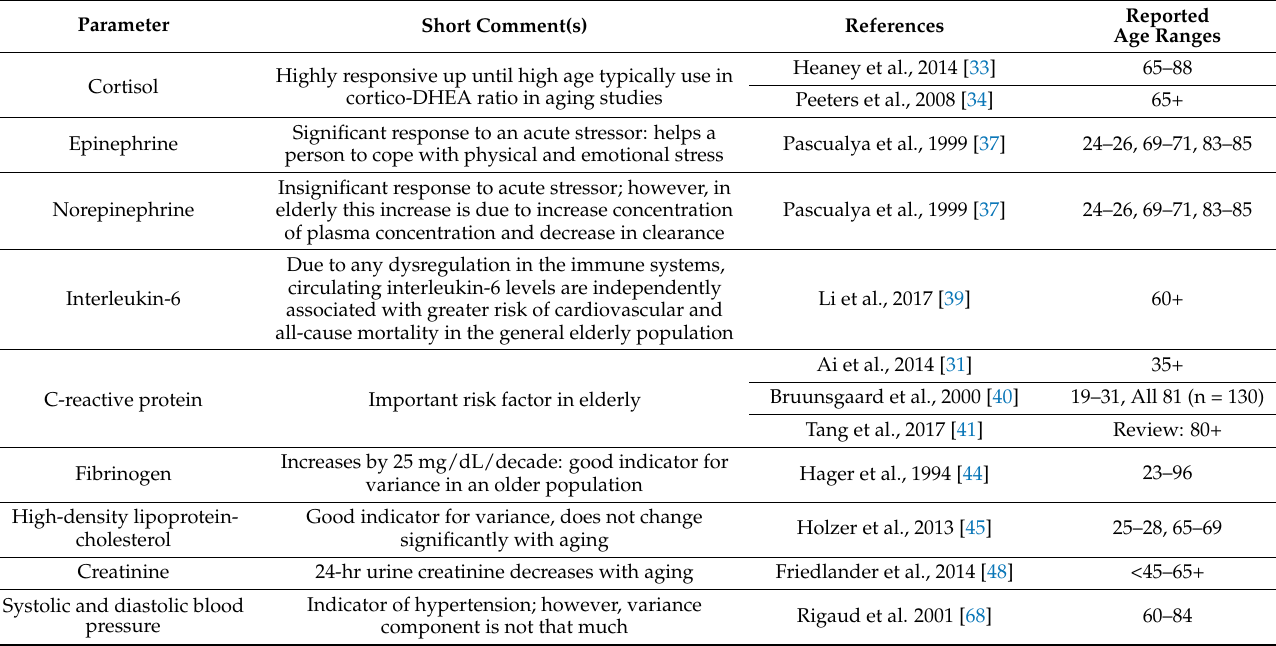
Table 4. Allostatic biomarkers with typical yet significant variability in elderly to capture adaptive or immediate reactive responses to exogenous stressors in